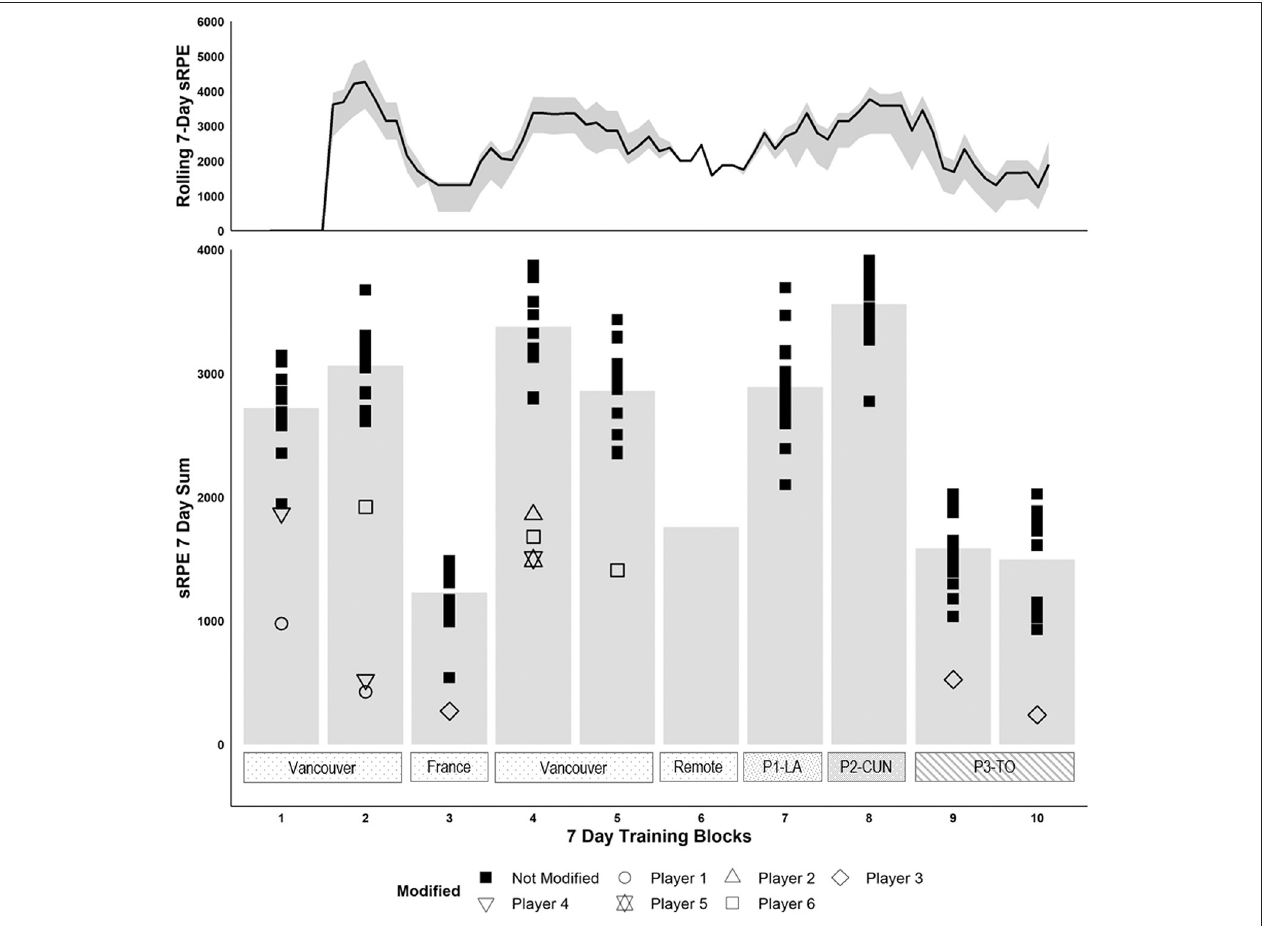
FIGURE 2 | Seven-day RPE rolling sum average (top) and RPE 7-day sum (bottom) across the 10-week world cup preparation. The shaded area in the top graph represents the maximum and minimum for the rolling 7-day sum average. Heat acclimatization occurred during phase 1 in Los Angeles (P1—LA) and phase 2 in Cancun (P2—CUN). Phase 3 was in Toronto in moderate climate